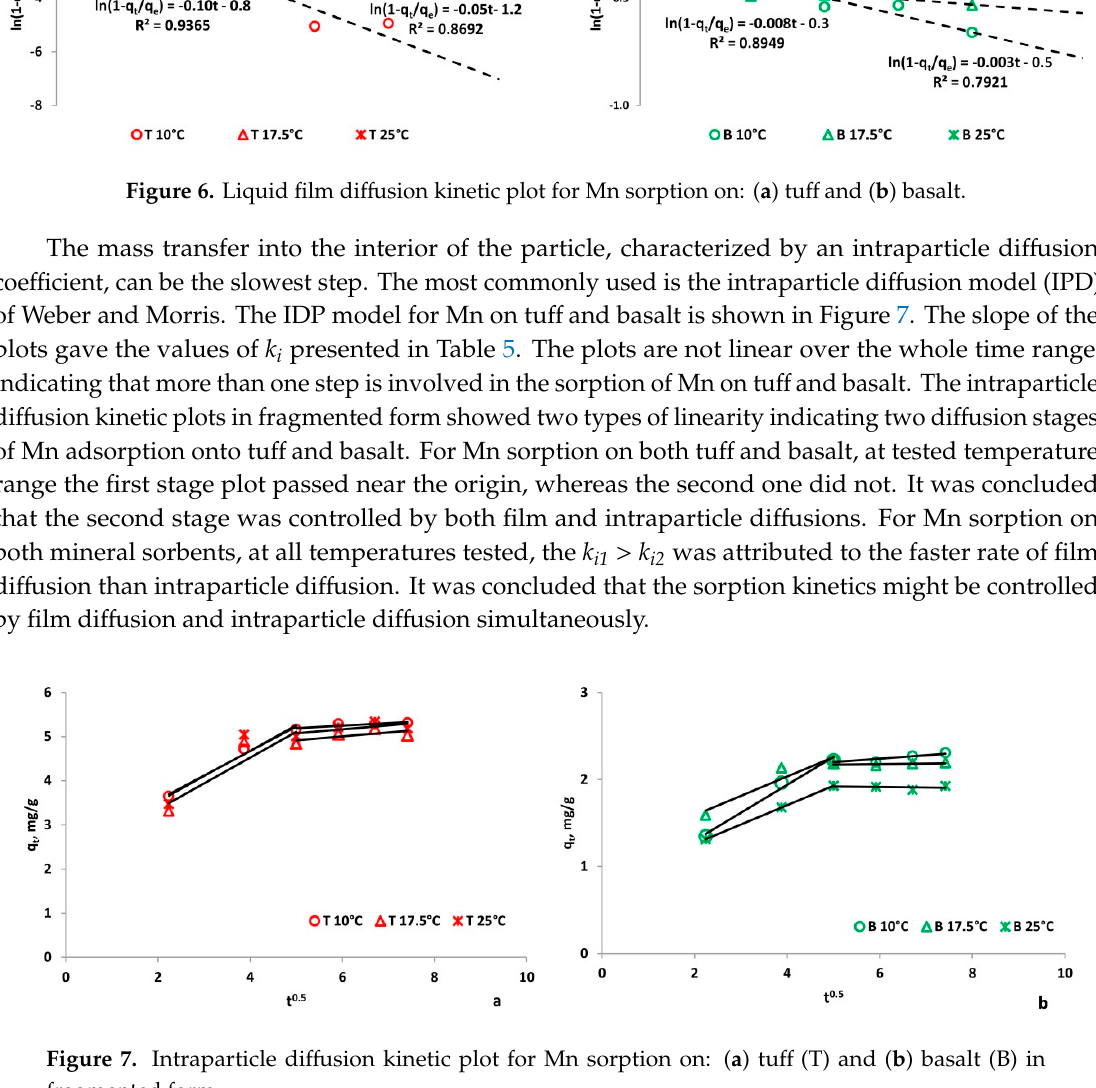
Figure 7. Intraparticle diffusion kinetic plot for Mn sorption on: ( a ) tuff (T) and ( b ) basalt (B) in fragmented form. Table 5. Parameters of intraparticle diffusion model, characterized by coefficient of determination and standard deviation.